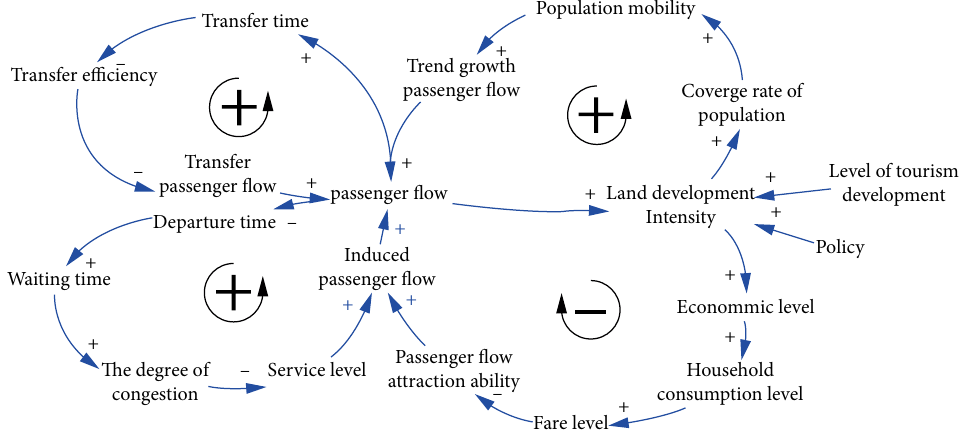
Figure 3: Passenger influencing variable causal loop diagram.